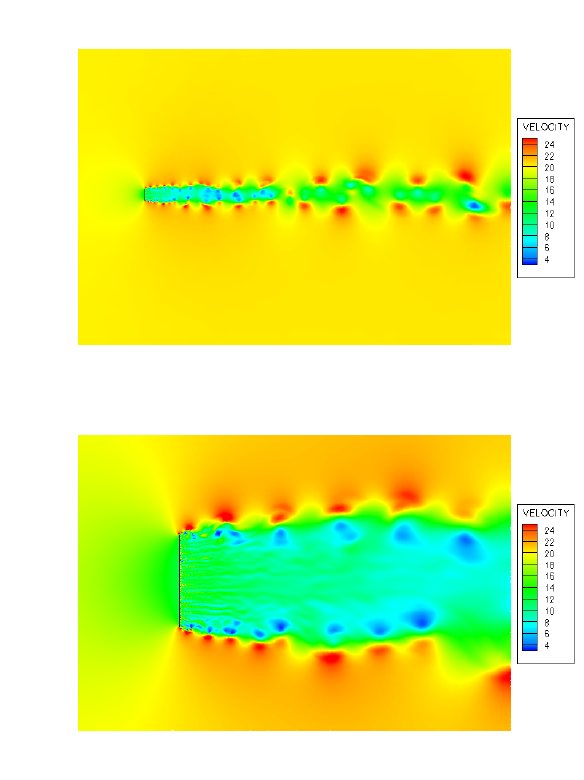
Fig. 4. The distribution of the velocity for the fence for 20 ms − 1 .